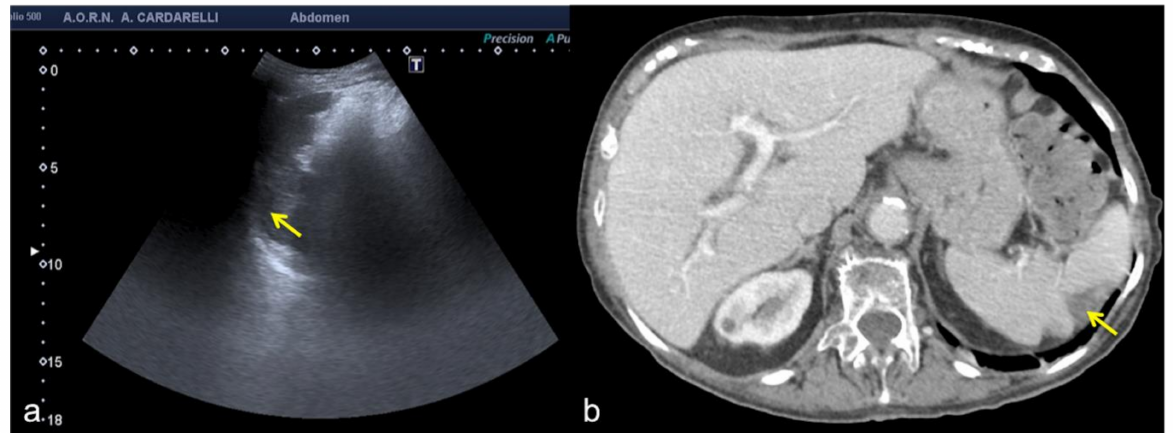
Figure 26. Coronal US scan of the left hypochondrium ( a ) shows partial exploration of the spleen with unrecognized traumatic injury (arrow) in a 22-year-old man investigated for trauma. On CT scan ( b ) it appears to be more evident